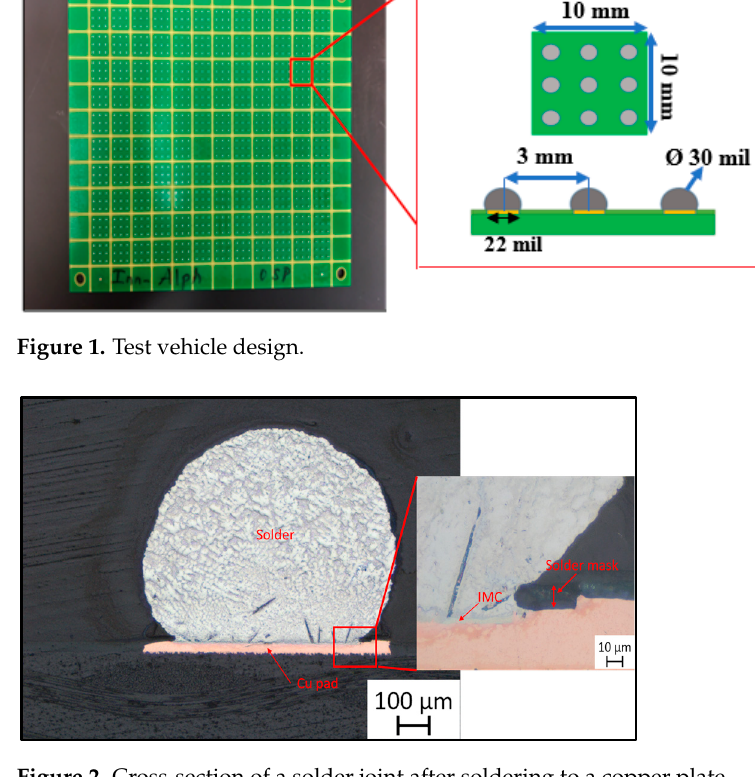
Figure 2. Cross-section of a solder joint after soldering to a copper plate.